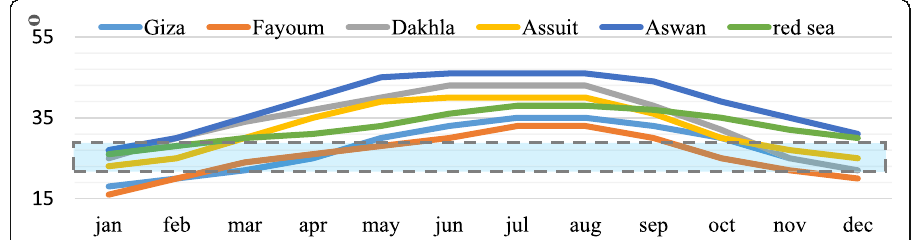
Fig. 4 Monthly most temperatures (°C) in choosing areas. Source: World meteorological